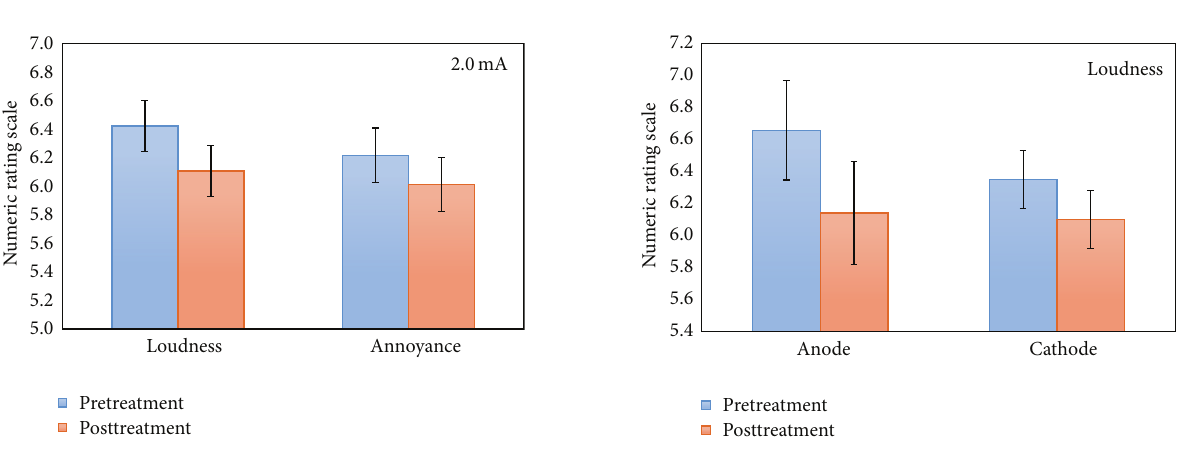
Figure 2: NRS loudness and annoyance pre- and posttreatment for the 2.0 mA group.